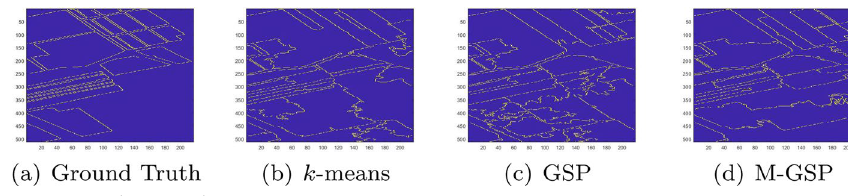
Fig. 15 Boundaries in Salinas